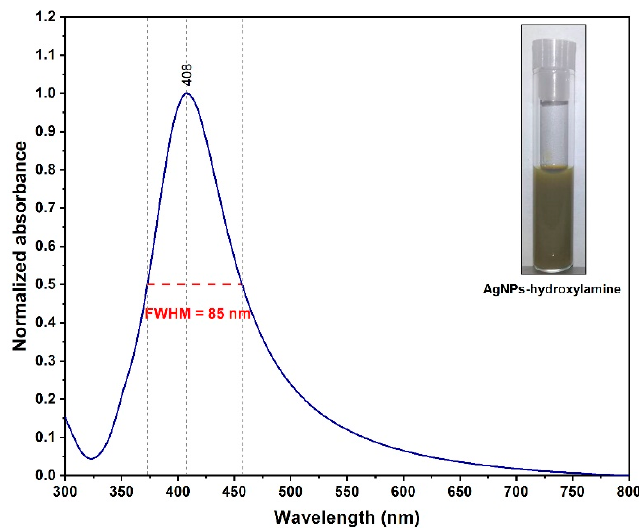
Figure 1. UV–VIS absorption spectrum of the filtered silver colloid. The inset presents an optical image of the concentrated colloidal solution. The full width at half maximum (FWHM) value is 85 nm.